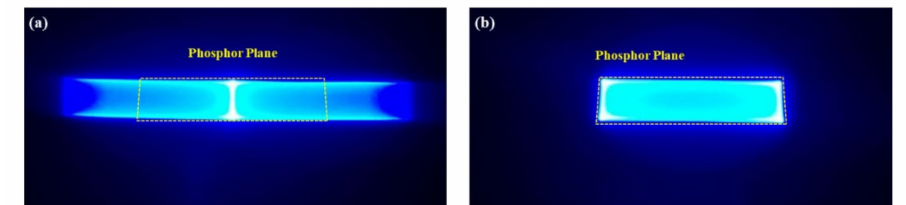
Figure 12. Distributions of light illuminated on phosphor plane by ( a ) designed scanner system and ( b ) scanning system without